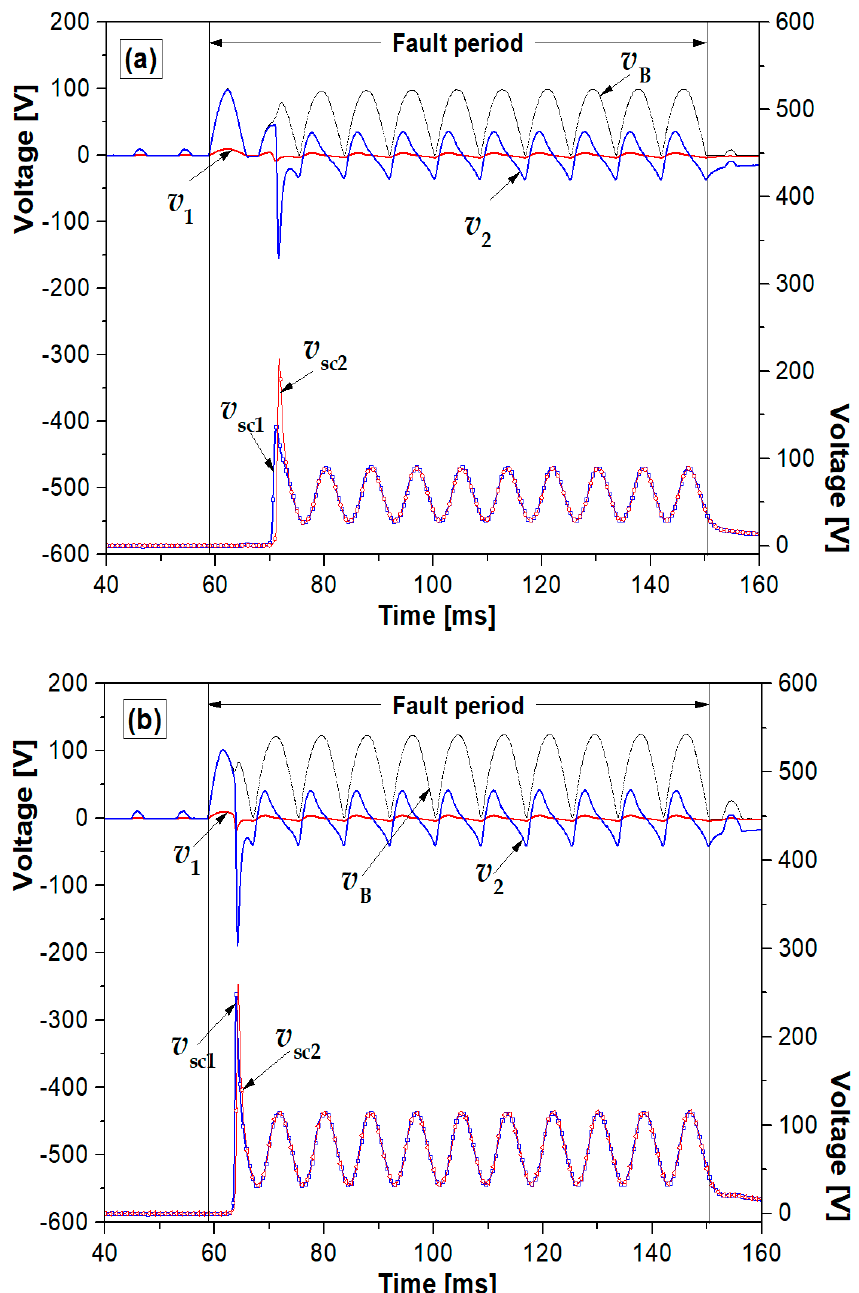
Figure 5. Voltage waveforms of full bridge circuit, each winding and HTSC elements ( v B , v 1 , v 2 and v SC 1 , v SC 2 ) according to the change of input voltage source. ( a ) E in = 80 V rms . ( b ) E in = 100 V rms .